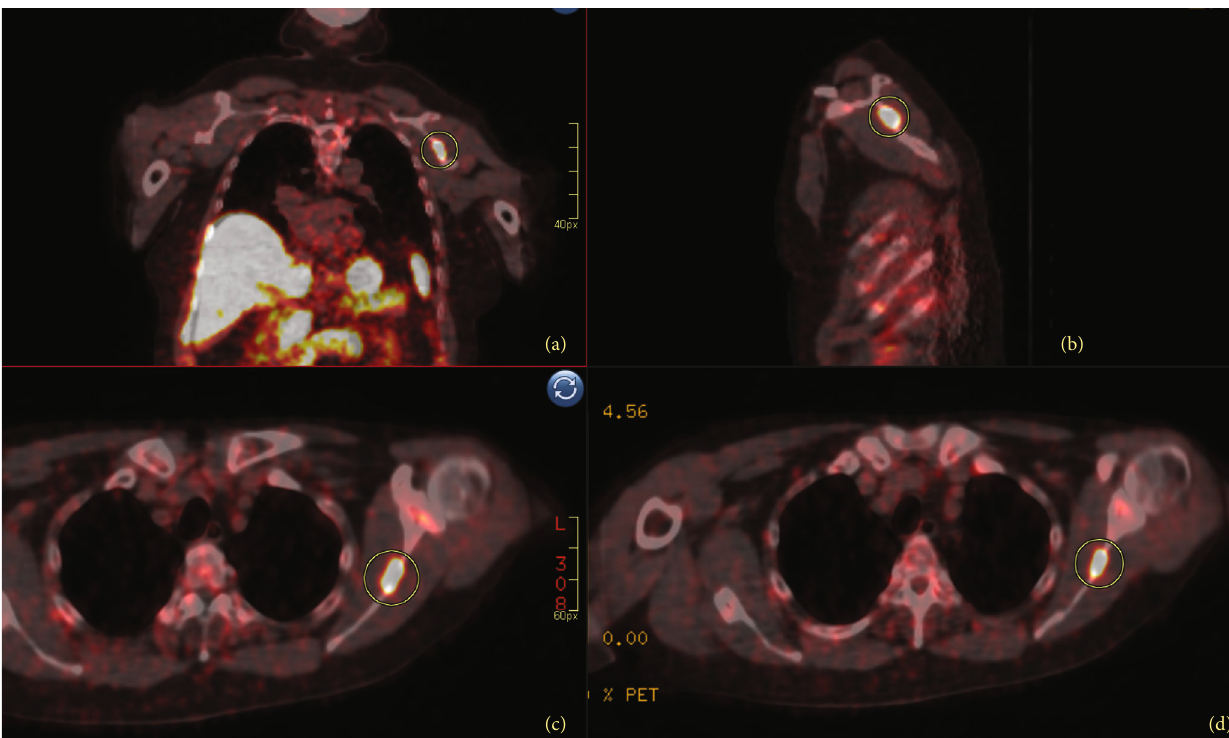
Figure 1: Case 1: left scapula 68 Ga-DOTATATE-PET/CT images. Coronal (a), sagittal (b), and two axial (c and d) 68 Ga-DOTATATE-PET/ CT images with multiple foci of mild uptake noted with bilateral ribs, costovertebral junctions, and left glenoid concerning for microfractures; and area of hyperintesnse uptake within the left scapula (circle) consistent with primary PMT secreting FGF-23.